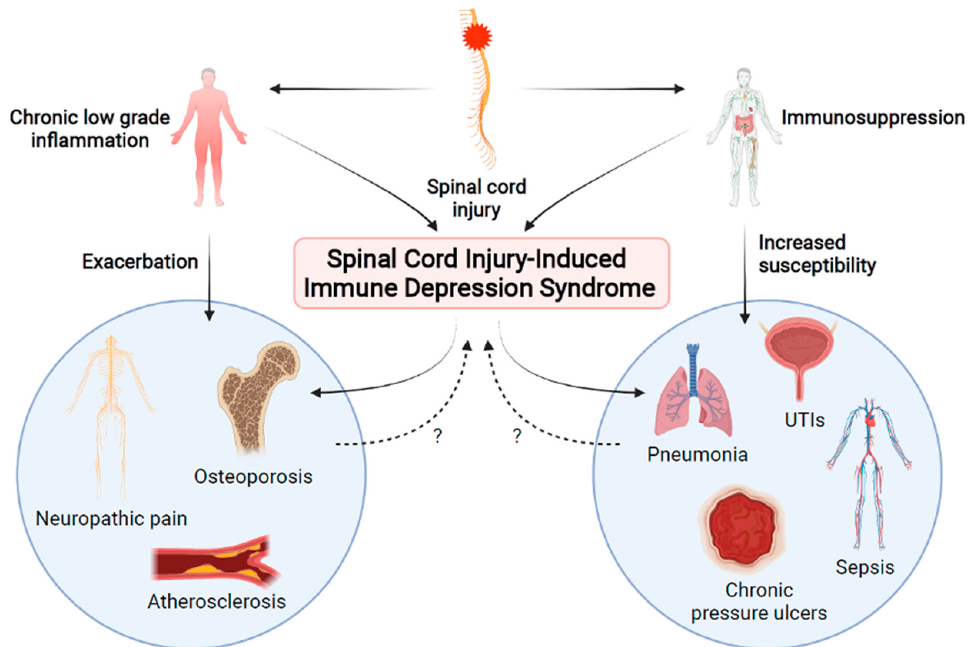
Figure 1. After spinal cord injury (SCI), both chronic systemic inflammation and immunosuppression result in SCI-induced immune depression syndrome (SCI-IDS). Altered immune function results in increased susceptibility to infection and exacerbated secondary complications of SCI. In turn, these secondary complications and infections may create a feedback loop which amplifies immune dysfunction. Created using BioRender.com accessed on 2 September 2021.